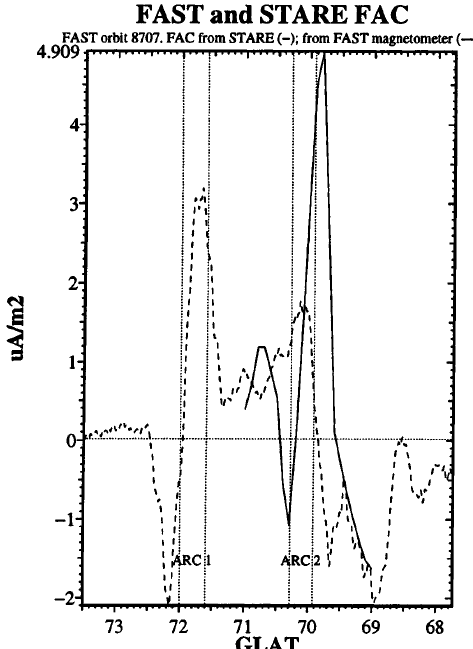
Fig. 10. The FAC determined from STARE and ground magneto- meters by the method of characteristics ( solid line ) is compared here with the FAC determined from FAST magnetometer ( dashed line ). Positive FAC is upward